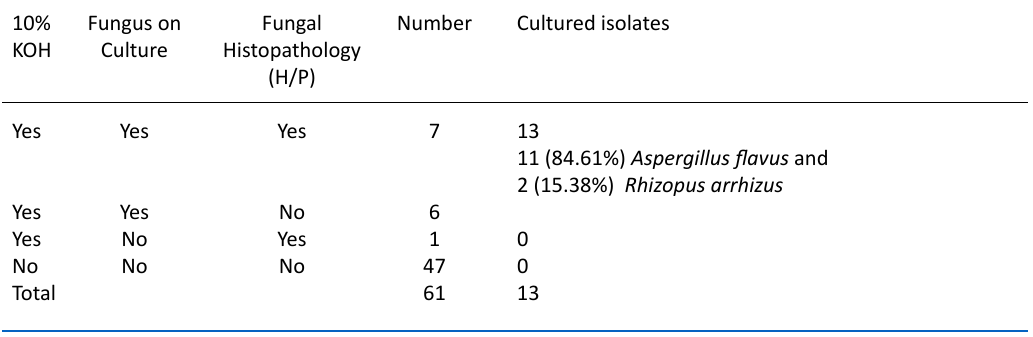
Table 1. Distribution of Chronic Fungal Rhino-sinusitis cases according to KOH, culture, and Histopathology finding 10% Fungus on Fungal Number Cultured isolates KOH Culture Histopathology (H/P)